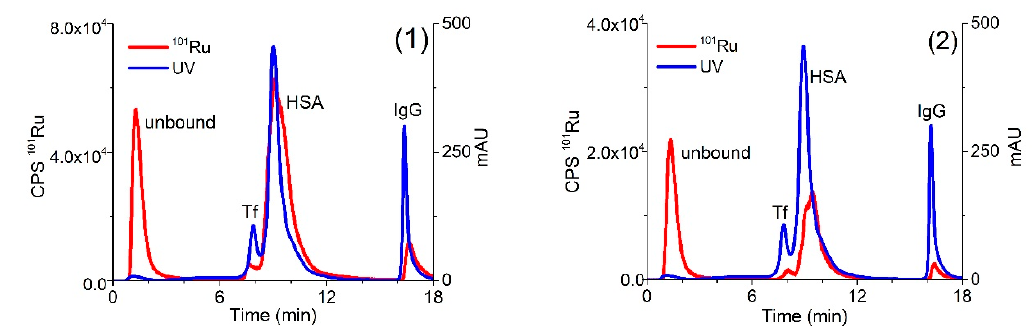
Figure 3 . Two-dimensional separation of 5-times diluted human serum spiked with complexes ( 1 ) (0.760 µg/mL Ru) or ( 2 ) (0.396 µg/mL Ru) on CLC monolithic column 24 h after incubation, followed by UV spectrometry at 278 nm and ICP-MS at m/z 101 detection.